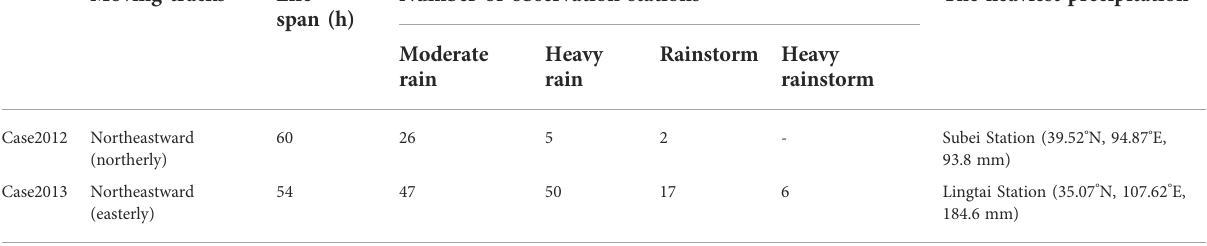
TABLE 1 Overview of precipitation (graded into four levels following the CMA ’ s criteria) and moving tracks of plateau vortex in Case2012 and Case2013. Moving tracks